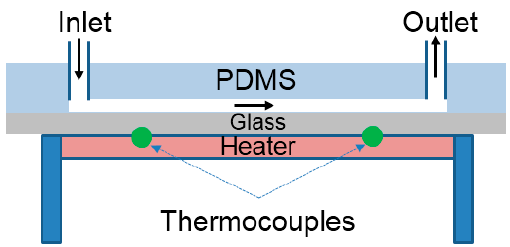
Figure 8. Experimental setup to evaluate the influence of temperature on separation.